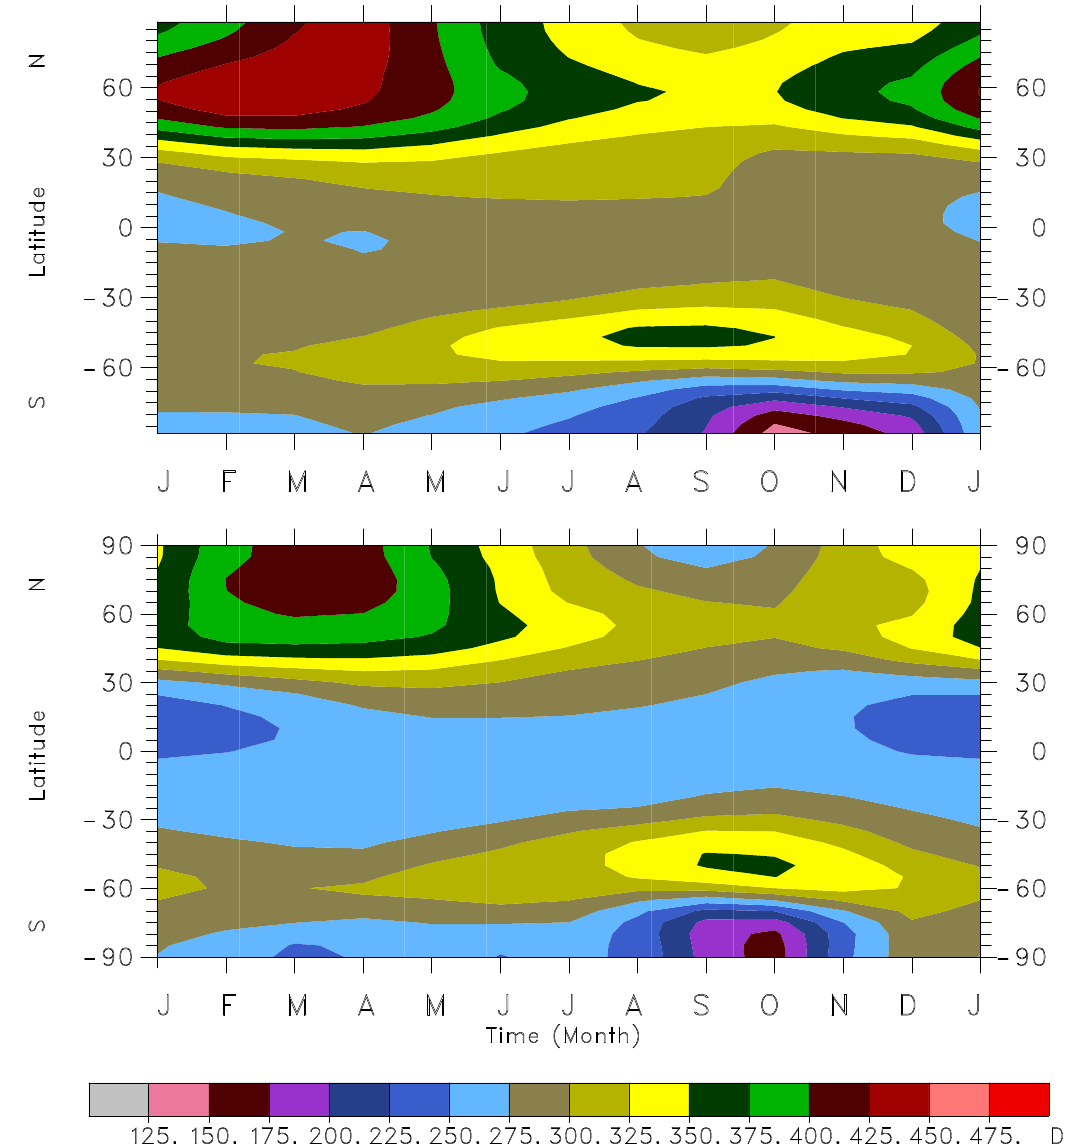
Fig. 8. Modeled (upper panel) and observed (lower panel) climatological zonal mean total ozone (Dobson Units). Model results are averaged over 20 simulated years. Observed data represent averages over the years 1985–1997 (Bojkov et al., 1999; Fioletov, pers. comm.